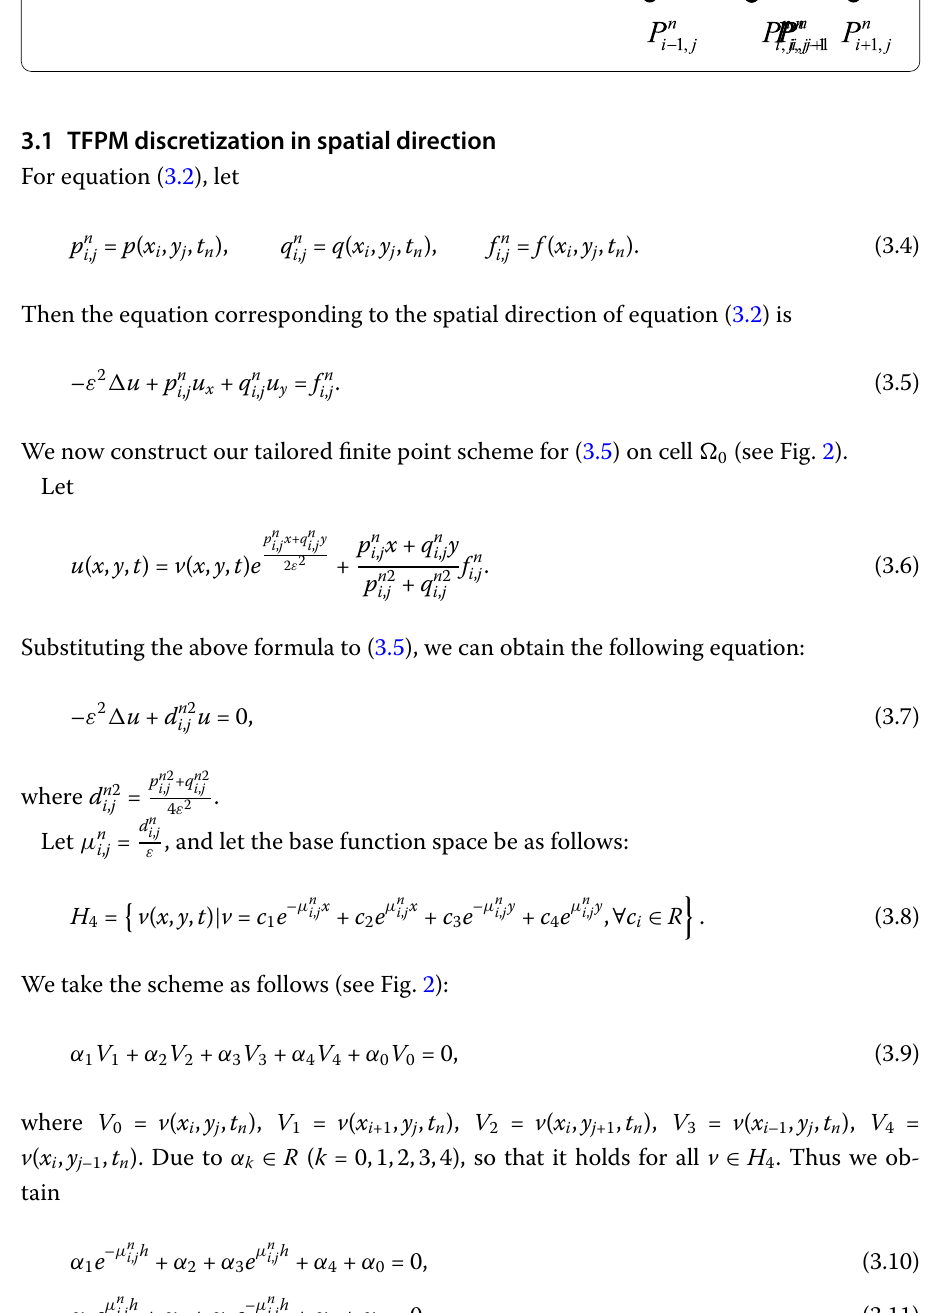
Figure 2 The local mesh for spatial